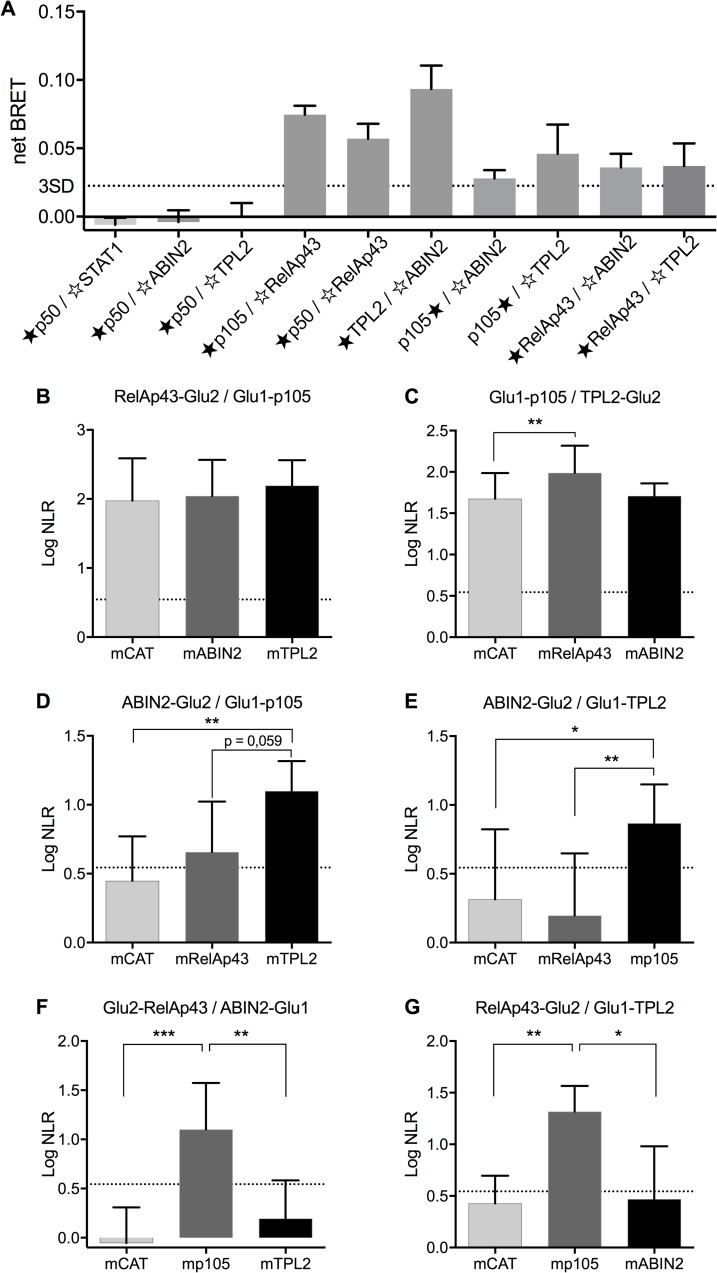
Characterization of the interactions between RelAp43, p105, ABIN2 and TPL2.A. Interactions between RelAp43, p105, ABIN2 and TPL2 assessed using BRET technology. HEK 293T cells were transfected for 48h with 2 plasmids encoding for Nluc(★)- and YFP(☆)-tagged proteins before measuring BRET. p50 and STAT1 were used as controls. A threshold (doted line) was determined at 0.025 of netBRET, based on the mean+3SD values obtained from non-interacting control pairs: p50-STAT1, -ABIN2 and -TPL2. Each value represents the mean of 3 independent experiments. Error bars represent the standard deviation. B-G. Interactions between RelAp43, p105, ABIN2 or TPL2 in presence or not of a third helper protein, using PCA technology. HEK 293T cells were transfected with 4 plasmids expressing: a Glu1-, a Glu2-, a cMyc-tagged protein and a firefly luciferase for 48h before measuring both gaussia and firefly activity. Position of the tag is indicated as follow: Glu1-, Glu2- for N-ter and -Glu1, -Glu2 for C-ter. Results are the mean of the logarithm of gaussia NLR values normalized to luciferase activity in at least 4 distinct experiments. A threshold of NLR = 3.5 previously described [54] was used to define the positive results (log 3.5 = 0.54). Error bars represent the standard deviation. ***p<0.001, **p<0.01; *p<0.05.